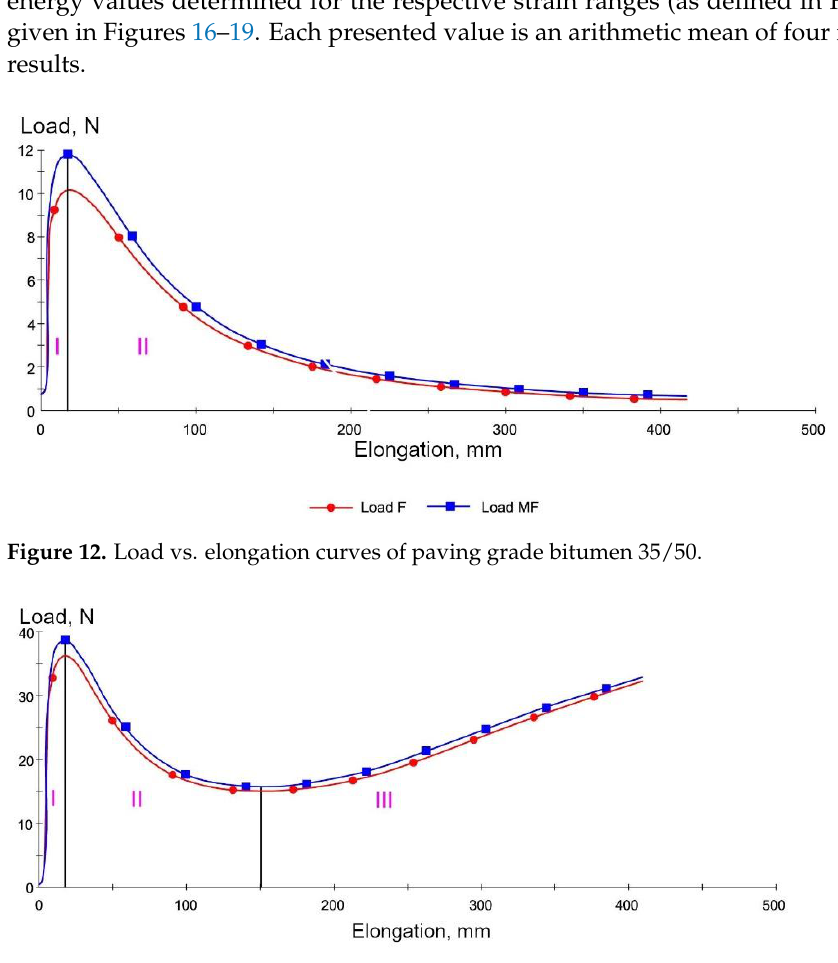
Figure 14. The maximum tensile force of SBS-modified asphalt binders determined using the force ductility test, error bars show a 95% confidence interval for the mean.